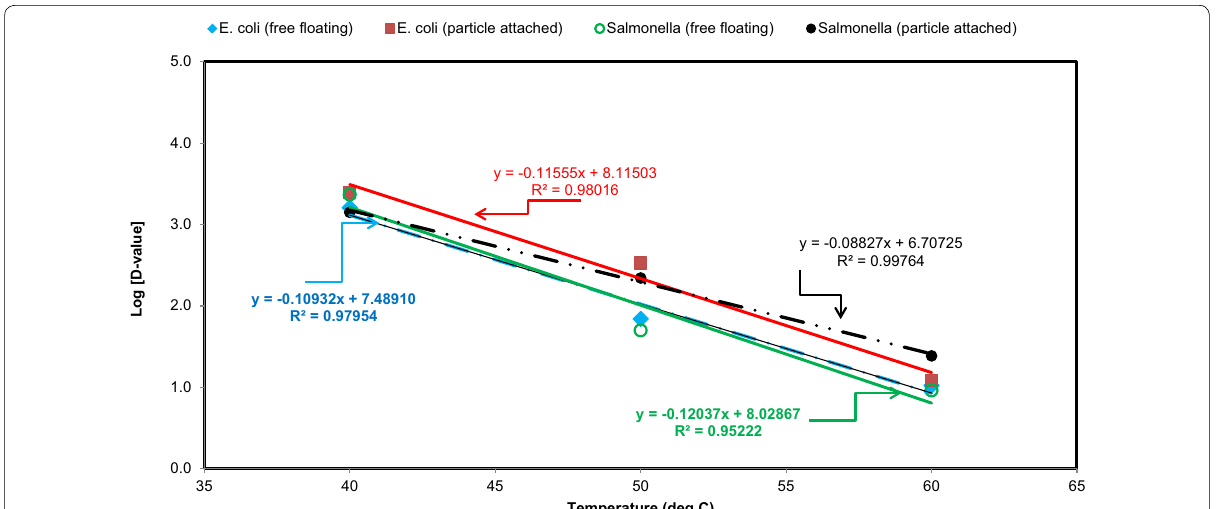
Fig. 9 Relationships between temperature and thermal reduction time (D-value) for Salmonella and E. coli O157:H7 . The D-values were estimated from Table 1 [D-value = −